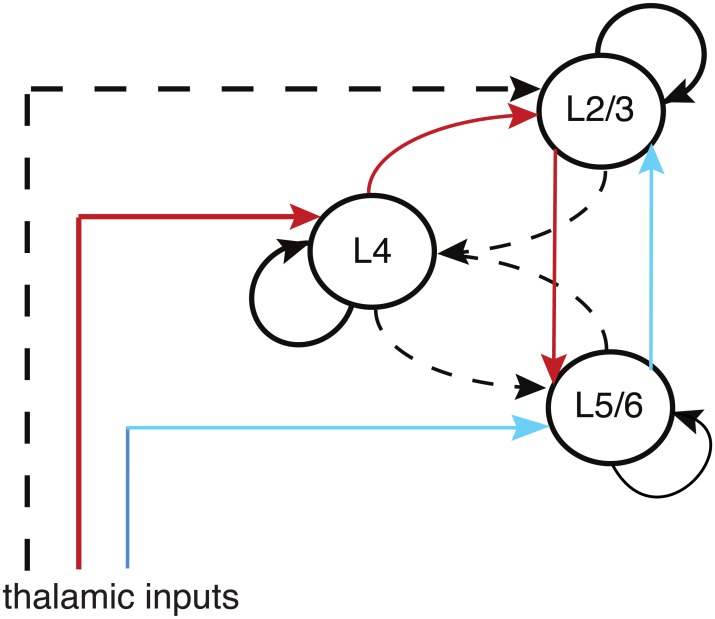
Schematic diagram illustrating an updated version of the classical microcircuit introduced by Douglas and Martin [68].This minimal circuitry comprises superficial (layers 2 and 3) and deep (layers 5 and 6) pyramidal cells and a population of smooth cells in layer 4C. Feedforward thalamic inputs target all cell populations. Weaker (modulatory) connections are shown in gray. In the original microcircuit model it was assumed that direct thalamic inputs to deep layers were weak. However, a recent experimental study indicates that these inputs are comparable to those innervating layer 4C [67]. Thus the classical direct pathway Th → L4 → L2/3 → L5/6 (red) is supplemented by an additional direct pathway Th → L5/6 → L2/3 (blue).